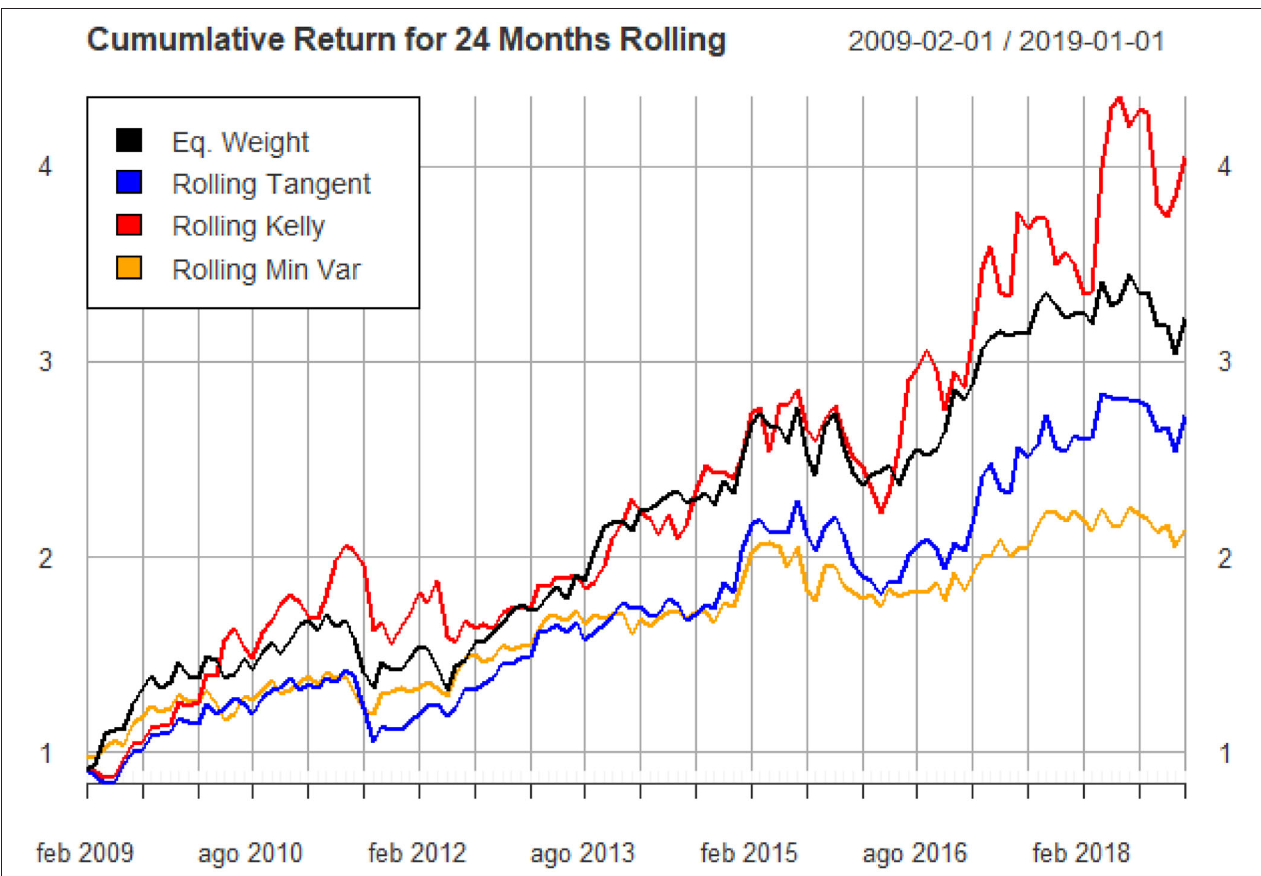
FIGURE 6 | Out of sample cumulative returns for 24-months rolling portfolios (monthly data).